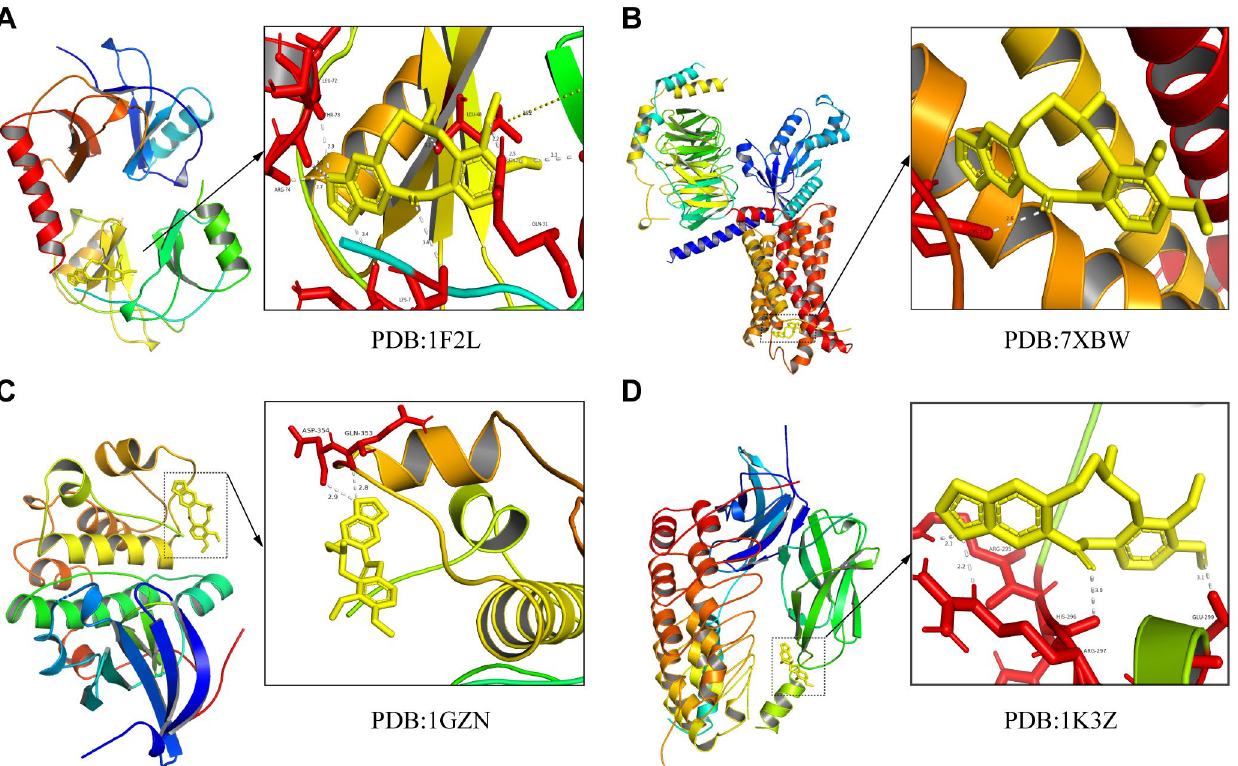
Figure 3. Molecular dock of ALL to CX3CL1 ( A ), CX3CR1 ( B ), AKT ( C ), and NF- κB p65 ( D ).